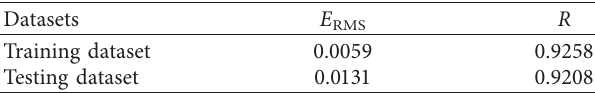
Figure 7: Comparison of permeability. (a) Training dataset. (b) Testing dataset. Table 5: Statistical parameters of actual and predicted permeability in the